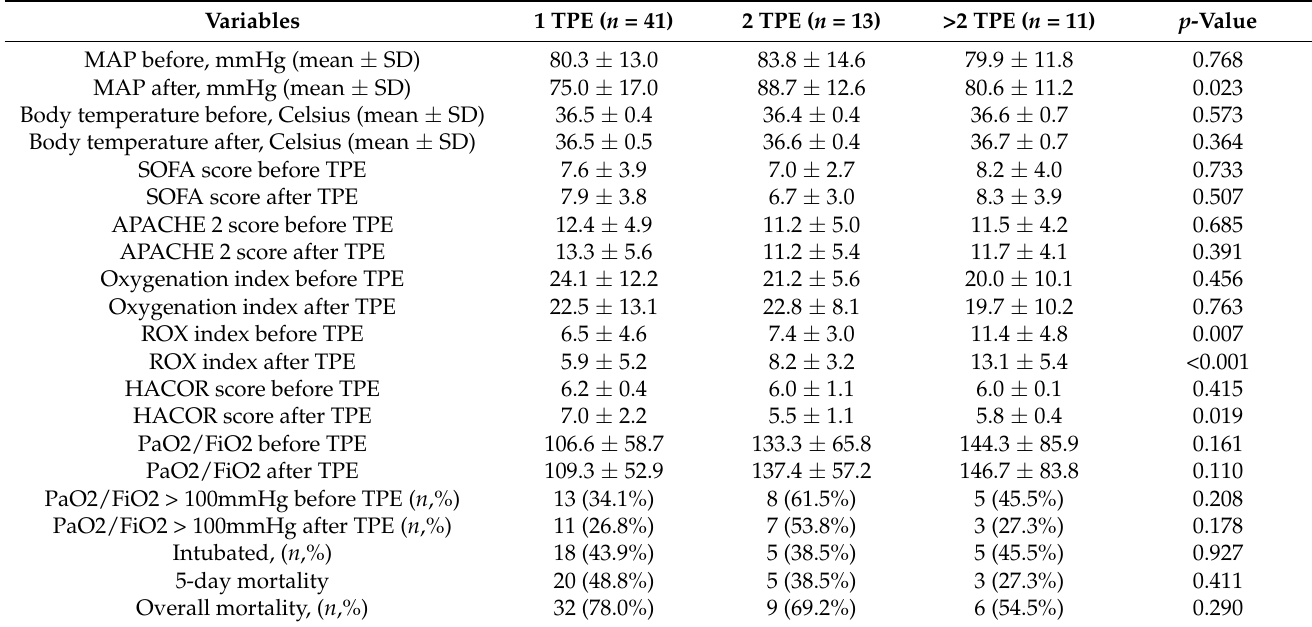
Table 4. Outcomes of patients with severe COVID-19 by number of TPE sessions.